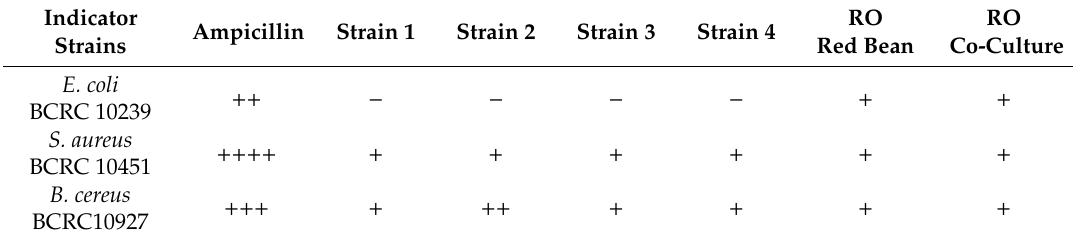
Table 1. Antimicrobial activity of tempeh substances produced by four kinds of fungus (1,2,3, and 4), R. microsporus var. oligosporus (RO) ( R. microsporus var. oligosporus IFO 8631 RO (ATCC 22959), and coculture (red bean inoculated with RO and Lactobacillus rhamnosus BCRC 16000).